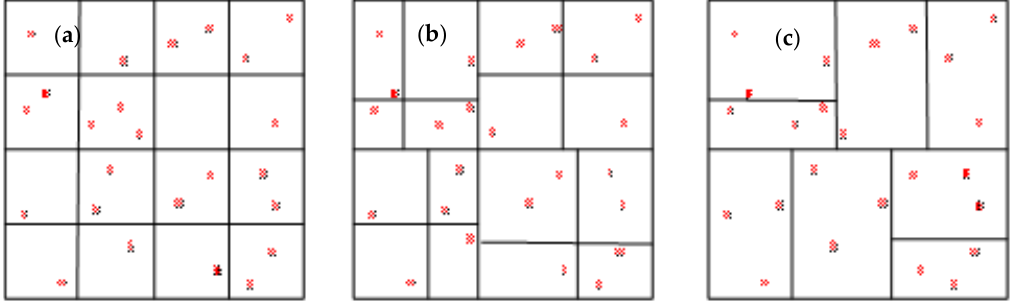
Figure 6. Various structural subdivision renderings. ( a ) A regular quadtree subdivision rendering. ( b )